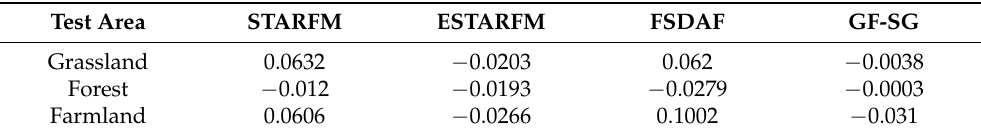
Table 2. AD of fusion results of different models with reference